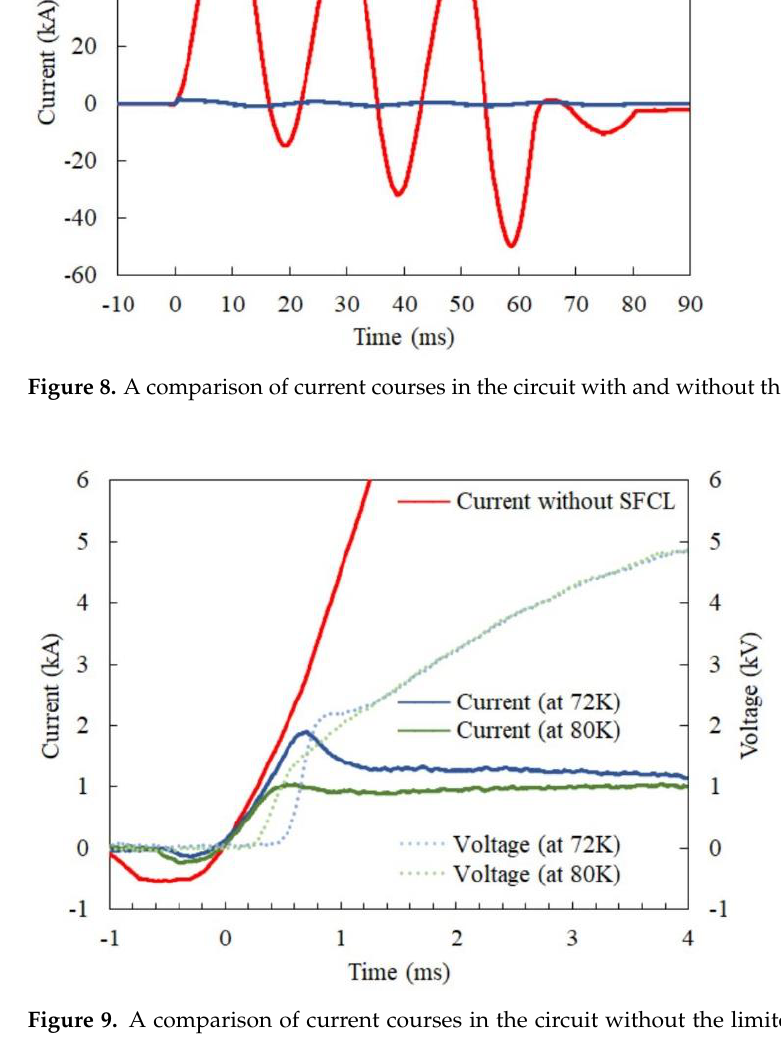
Figure 9. A comparison of current courses in the circuit without the limiter and with the limiter during the first 10 during the first 10 ms.